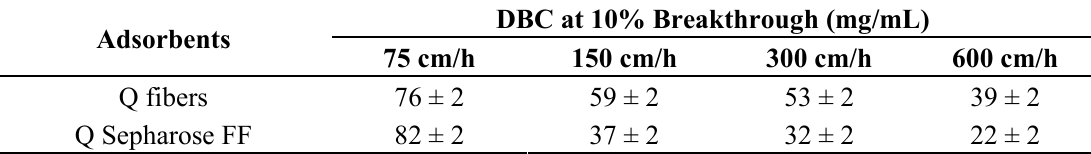
Figure 7. Dynamic binding capacity versus flow velocity for two different diameter columns packed with Q fibrous adsorbent at four different flow rates (75, 150, 300 and 600 cm/h). Conditions: 20 mM phosphate buffer, pH 7.4, was used as the equilibration buffer, and the sample (BSA 2 mg/mL) was dissolved in running buffer. (●) Column: 5 mm ID × 5.5 cm L; (▲) column: 50 mm ID × 5.5 cm L. Table 1. Comparison of binding capacities under static and dynamic conditions of anion exchange